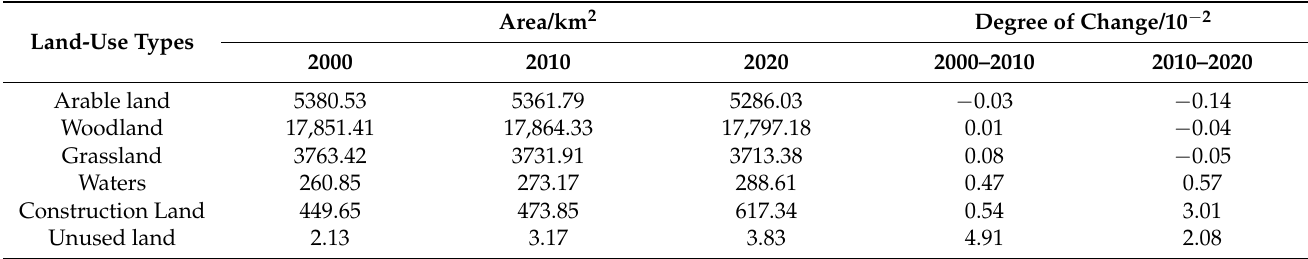
Table 2. The area and changes of land-use types in Guilin between 2000 and